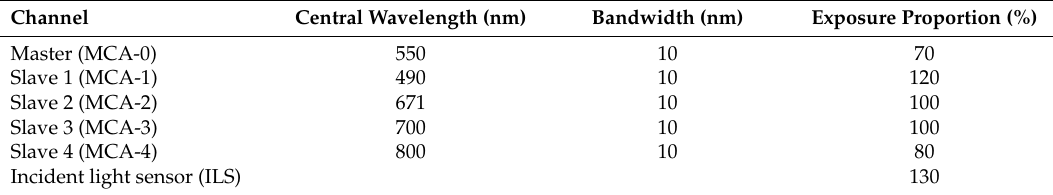
Figure 1. A photo of the Tetracam Mini-MCA6. ILS, incident light sensor. Table 1. The performance parameters of the Tetracam